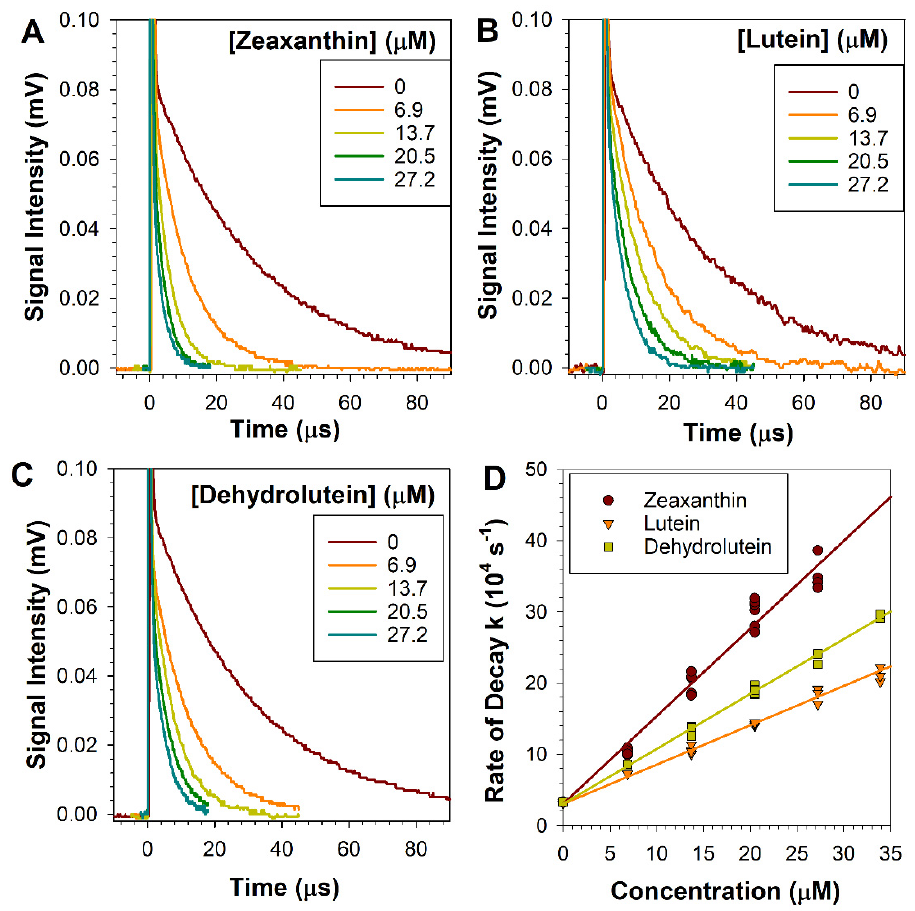
Figure 2. Dehydrolutein quenches singlet oxygen with a similar efficiency to that of lutein or zeaxanthin . ( A – C ): Representative kinetics of formation and decay of singlet oxygen after a 5-ns laser pulse photoexcitation of all- trans -retinal values in the absence and presence of dehydrolutein, lutein, and zeaxanthin at indicated concentrations. Time 0 indicates when the sample was exposed to the laser flash. The decays were fitted to exponential decay curves to obtain fitted parameters corresponding to the rates of decay. ( D ): Rates of singlet oxygen decay plotted as a function of carotenoid concentration. The quenching rate constants were determined by fitting straight lines to obtain the fitted slopes, which correspond to the rates of quenching.